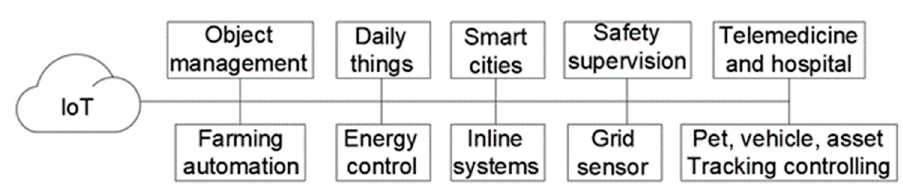
Figure 9. Smart Cities and IoT.